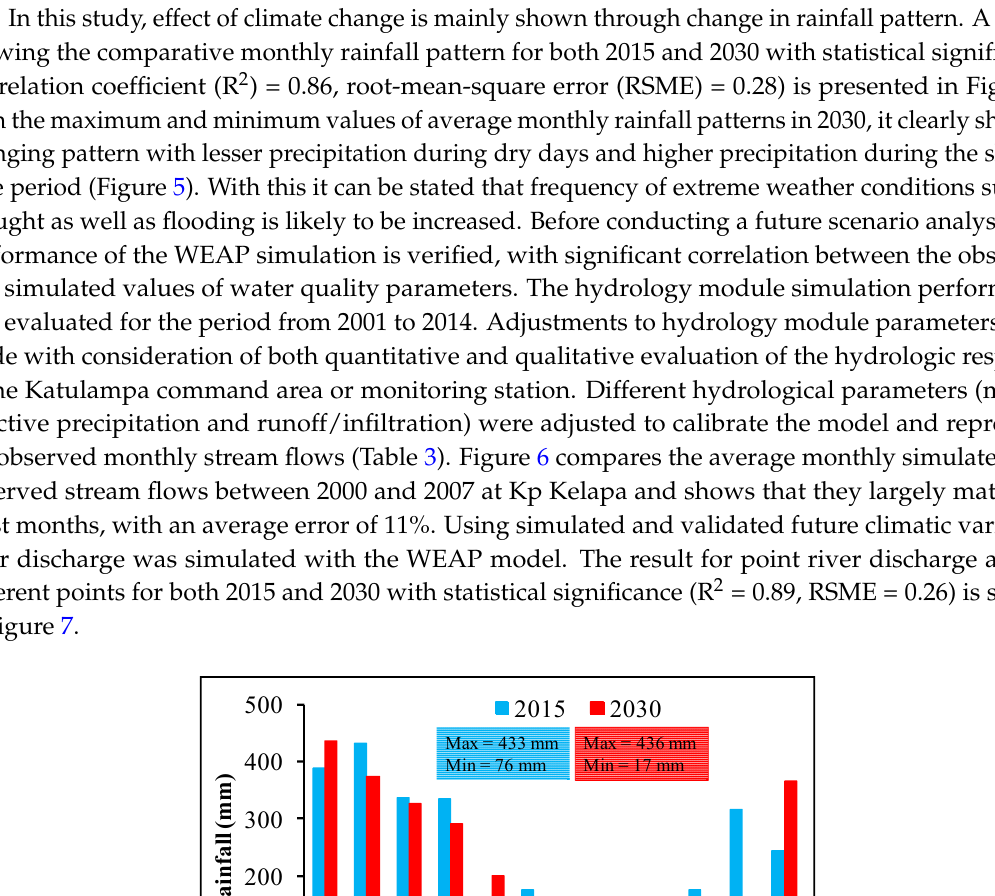
Table 2. Existing (functional) and planned wastewater treatment plants in DKI Jakarta. BOD: biochemical oxygen demand.